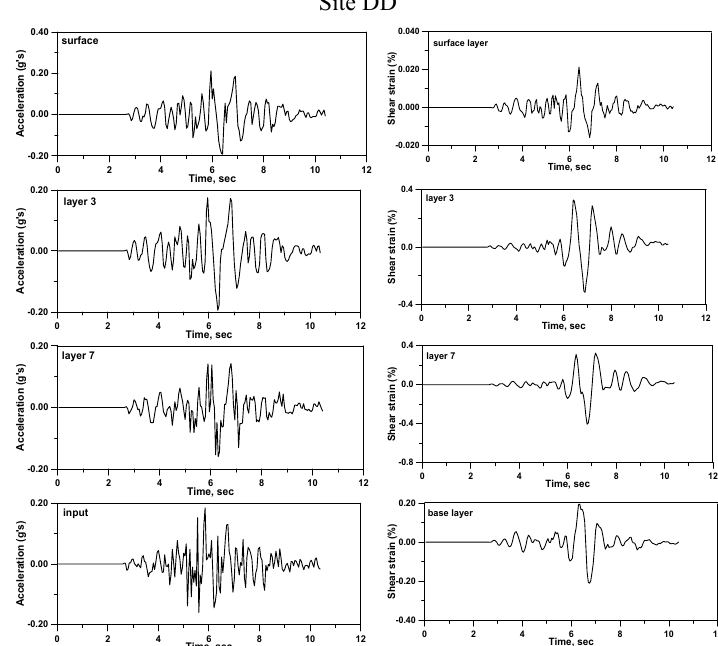
Figure 17 Fig. 17. Acceleration (left column) and strain (right column) time histories at different ground level.